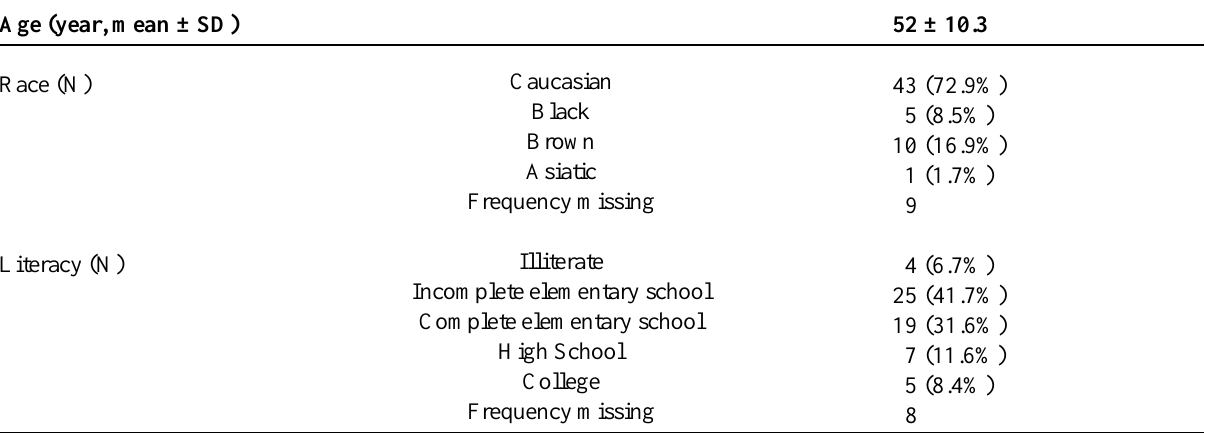
Table 1 – Background data on all patients assessed using the King’s Health Questionnaire.